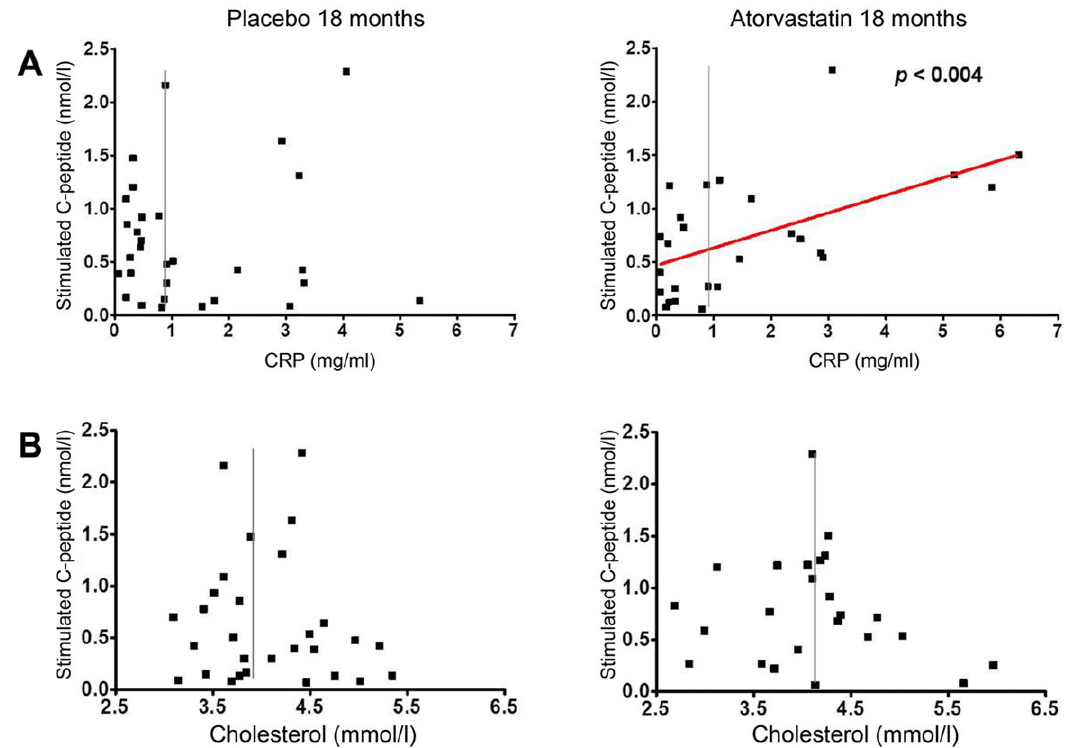
Figure 1. Correlation analysis of baseline CRP or total serum cholesterol concentrations with C-peptide outcome. Of individual patients, baseline CRP concentrations ( a ) or baseline total cholesterol levels ( b ) were compared to stimulated C-peptide concentrations at 18 months (18 m). The vertical line indicates the median of baseline CRP or cholesterol concentrations, respectively, the red line indicates the linear regression line obtained by the Pearson’s correlation test.